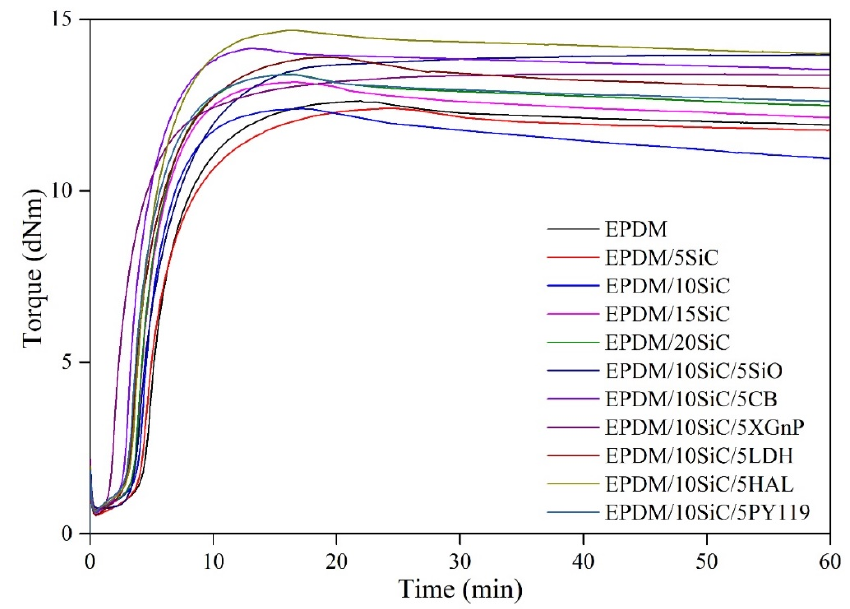
Figure 1. Rheometric curves for EPDM rubber compounds filled with SiC or SiC hybrid systems. Table 2. Rheometric parameters for EPDM rubber compounds filled with SiC or SiC hybrid systems.